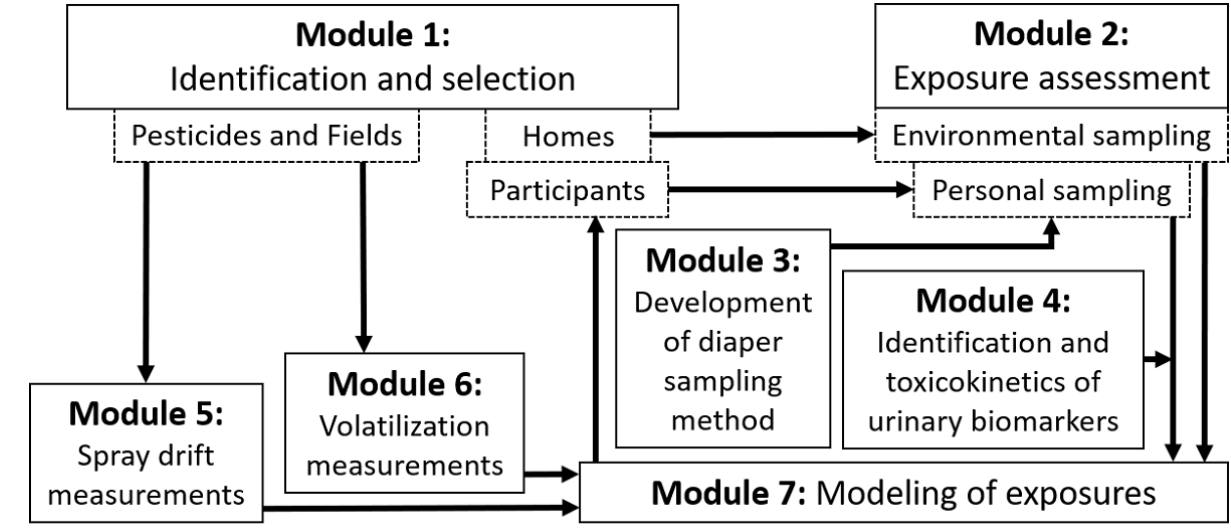
Figure 1. Schematic of the study design.